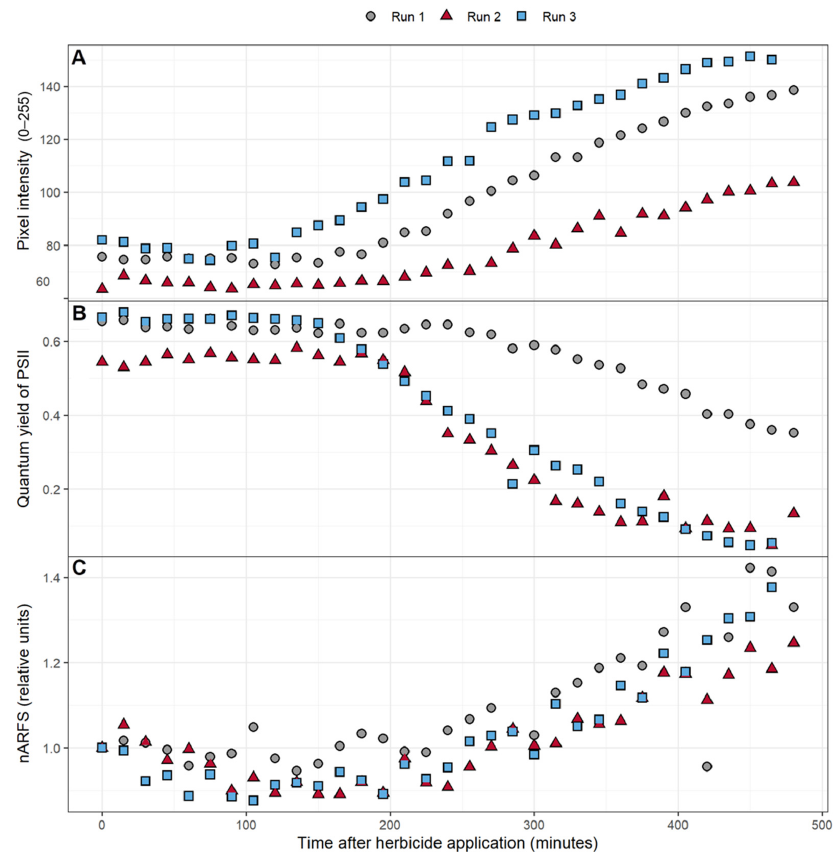
Figure 4. The effect of atrazine application on: ( A ) the average pixel intensity of a 50 pixel by 50 pixel area near where the other measurements were taken, ( B ) the quantum yield of PSII, ( C ) and the normalized average reflectance of the reflectance spectrum (nARFS) of Catharanthus roseus over an 8-h period. The nARFS was determined by averaging the normalized reflectance in the chlorophyll fluorescence spectrum (669.8–760.7 nm) and dividing that value by the value from the first reflectance measurement after herbicide application. Sensors 2021 , 21 , x FOR PEER REVIEW